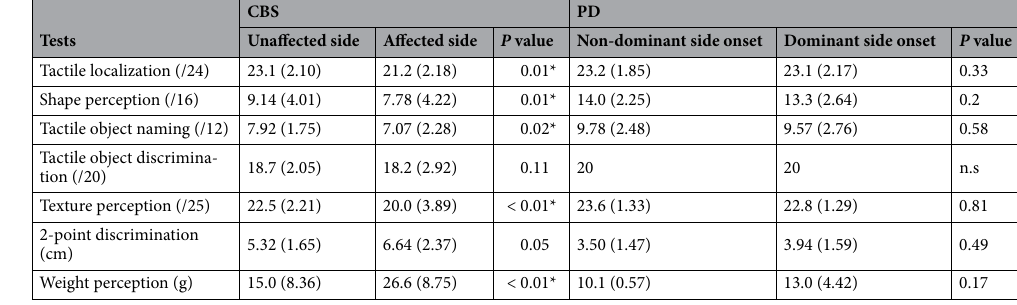
Table 2. Results of somatosensory test in the CBS and PD groups. In the PD group, none of the items showed a significant difference between the dominant-side onset and the non-dominant side onset. In the CBS group, all items showed a worse score in the affected side and 5/7 items showed a statistically significant worse score in the affected side (*). n.s. not significant.